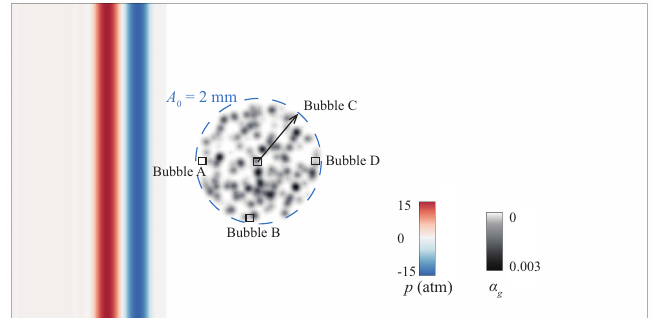
Figure 8. Initial setup of the simulation of a bubble cloud interacting with pressure wave. The radius of the bubble cloud is A 0 = 2 mm, and it has 200 bubbles with random size distribution between 1 µ m and 5 µ m. The computation domain is 2 L × L ( L = 10.24 mm). The distribution of the gas bubbles is visualized by both the volume fraction α g and the radius R b of Lagrangian spherical particles. Four bubbles (bubble A, B, C, and D) located at the four boxes’ centers are marked for future